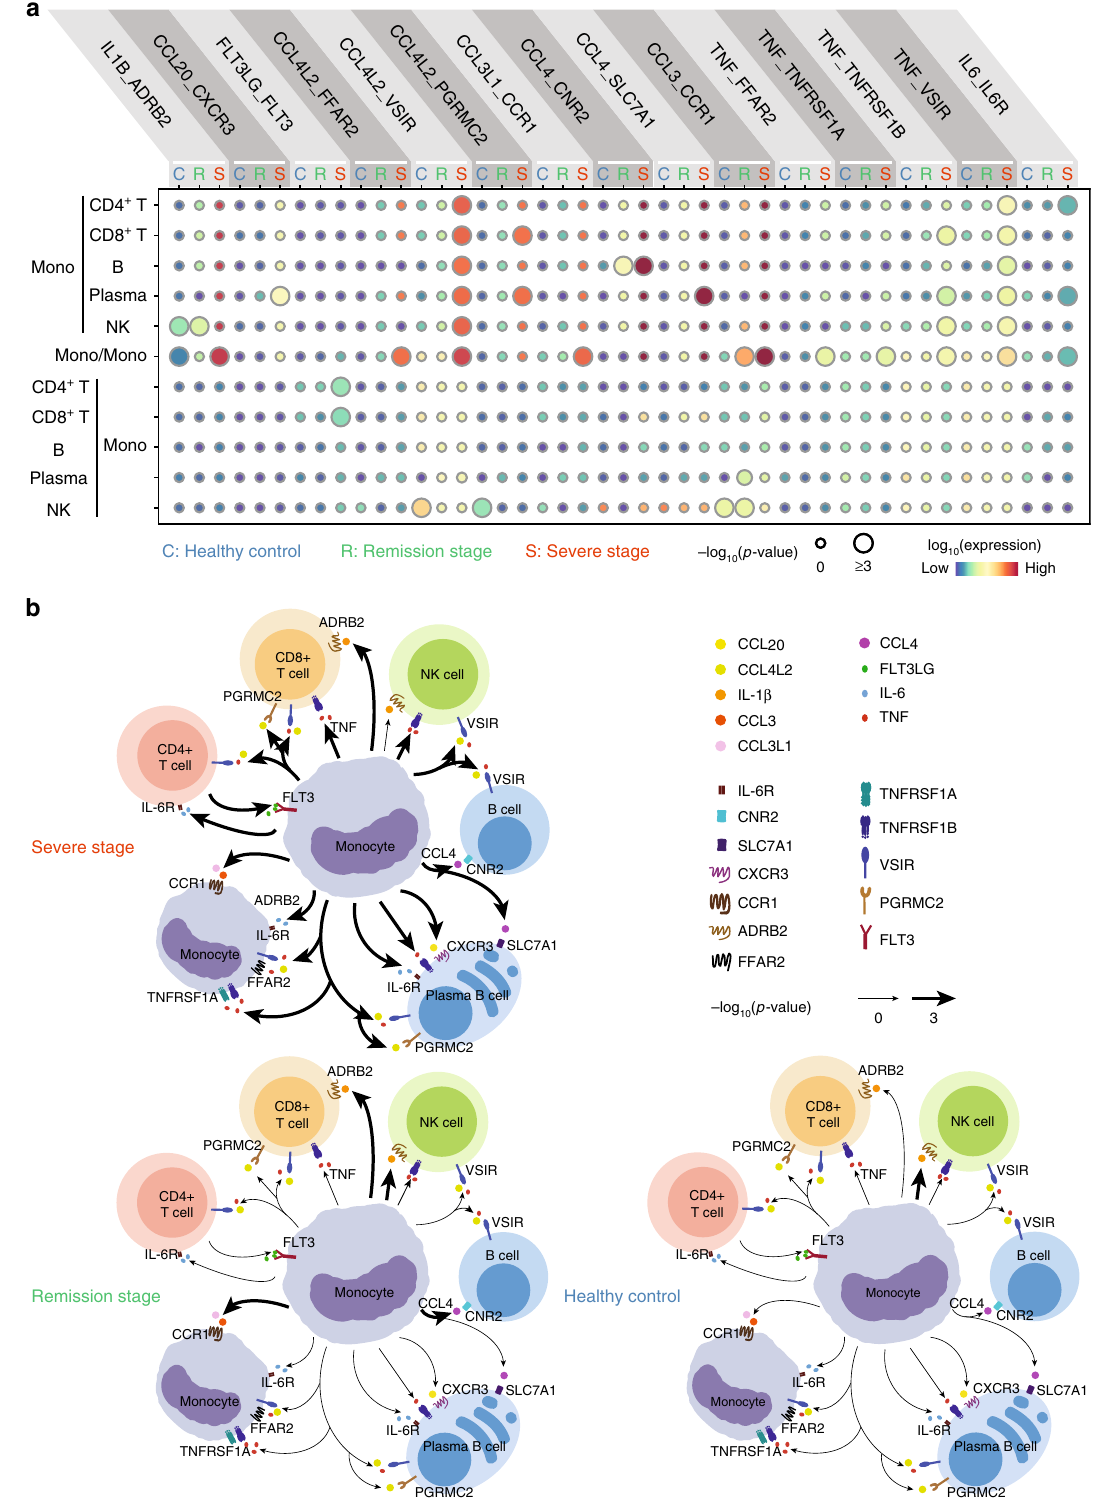
Fig. 3 The monocyte-centric molecular interactions of peripheral immune cells in severe-stage COVID-19 patients. a Dot plot of the predicted interactions between monocytes and the indicated immune cell types in the severe and remission stages and in healthy control individuals. P values are indicated by the circle sizes, as shown in the scale on the right (permutation test). The means of the average expression level of interacting molecule 1 in cluster 1 and interacting molecule 2 in cluster 2 are indicated by the colour. Assays were carried out at the mRNA level but were extrapolated to protein interactions. b Summary illustration depicting the potential cytokine/receptor interactions between monocytes and other types of peripheral immune cells in the severe and remission stages and in healthy control individuals. Bolded lines indicate predicted enriched cytokine/receptor interactions between monocytes and other immune cell